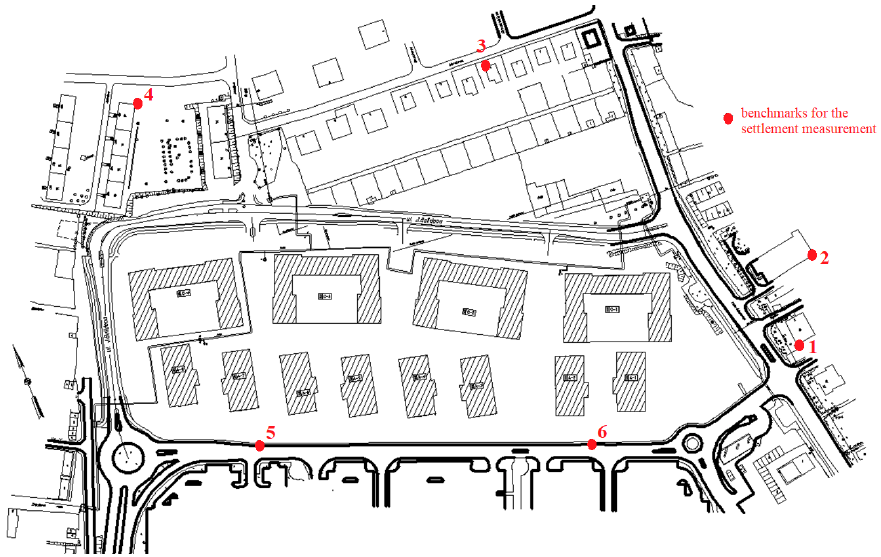
Figure 16. Construction site of the “Oak Terraces” housing estate in Katowice.